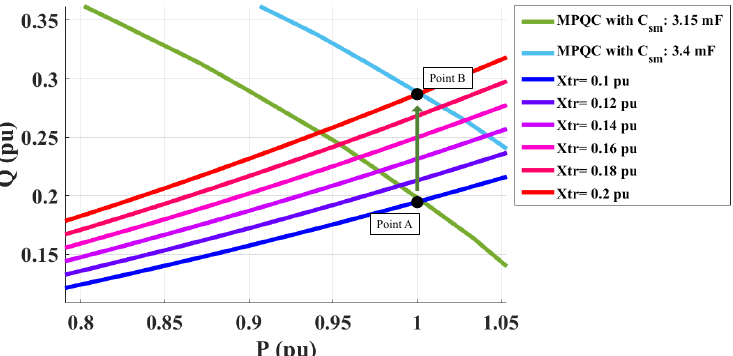
Figure 7. Change in PQ loading curves of MMC with different transformer leakage impedance